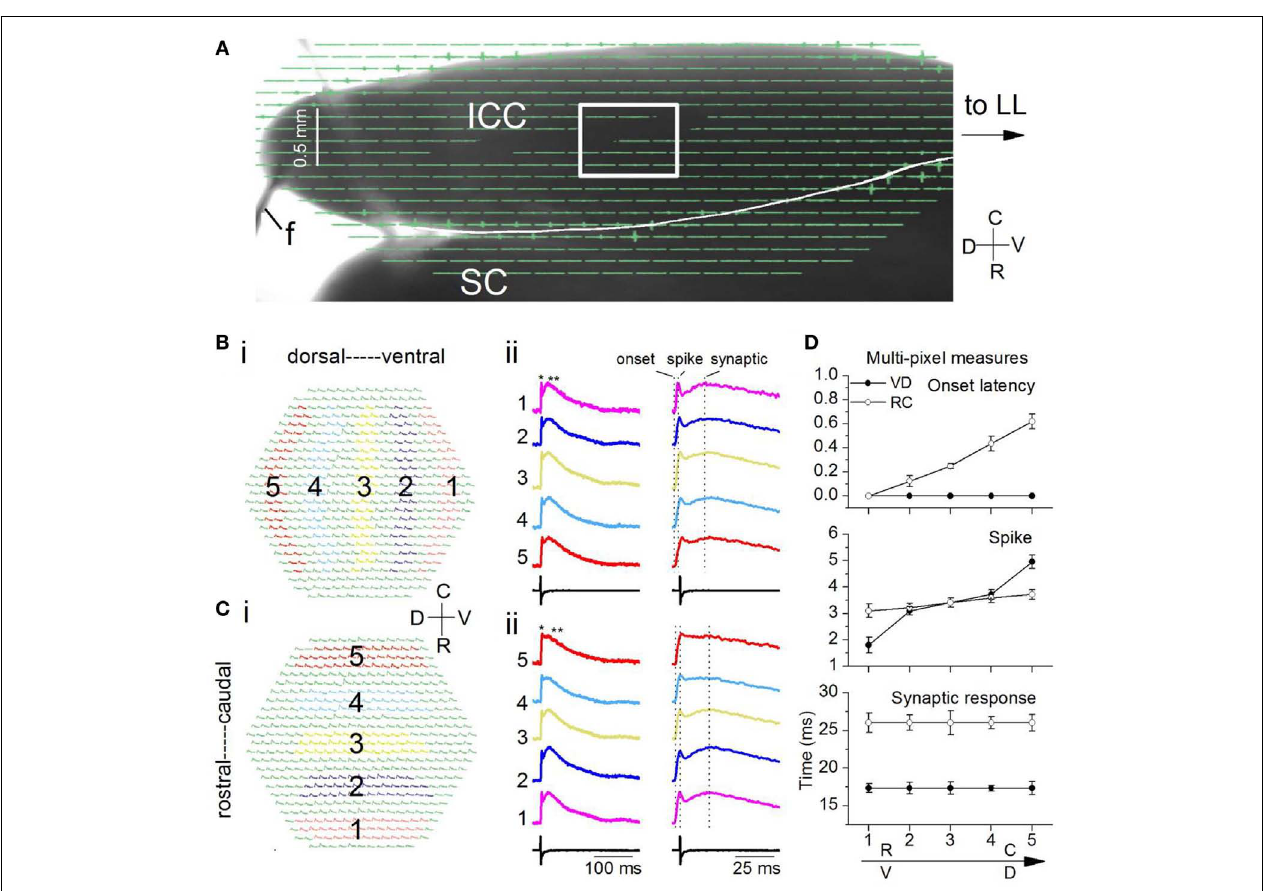
the color-coded areas in the ventral-dorsal and rostral-caudal directions; single asterisk, spike; double asterisk, synaptic response; Right columns, expanded traces to show onset latencies and peak times (vertical dotted lines). (C) (i) Areas in the rostral (1) toward the caudal (5) region. (ii) Left and right columns are as in (B) . (D) Response times along the ventral-dorsal (V-D) and rostral-caudal (R-C) directions.Top, onset; middle, first peak/spike; bottom, second peak/synaptic response.Times were measured with respect to onset in the ventral or rostral ICC (area 1). Each point is the average of 3–10 trials in each of 14 slices. Error bars are